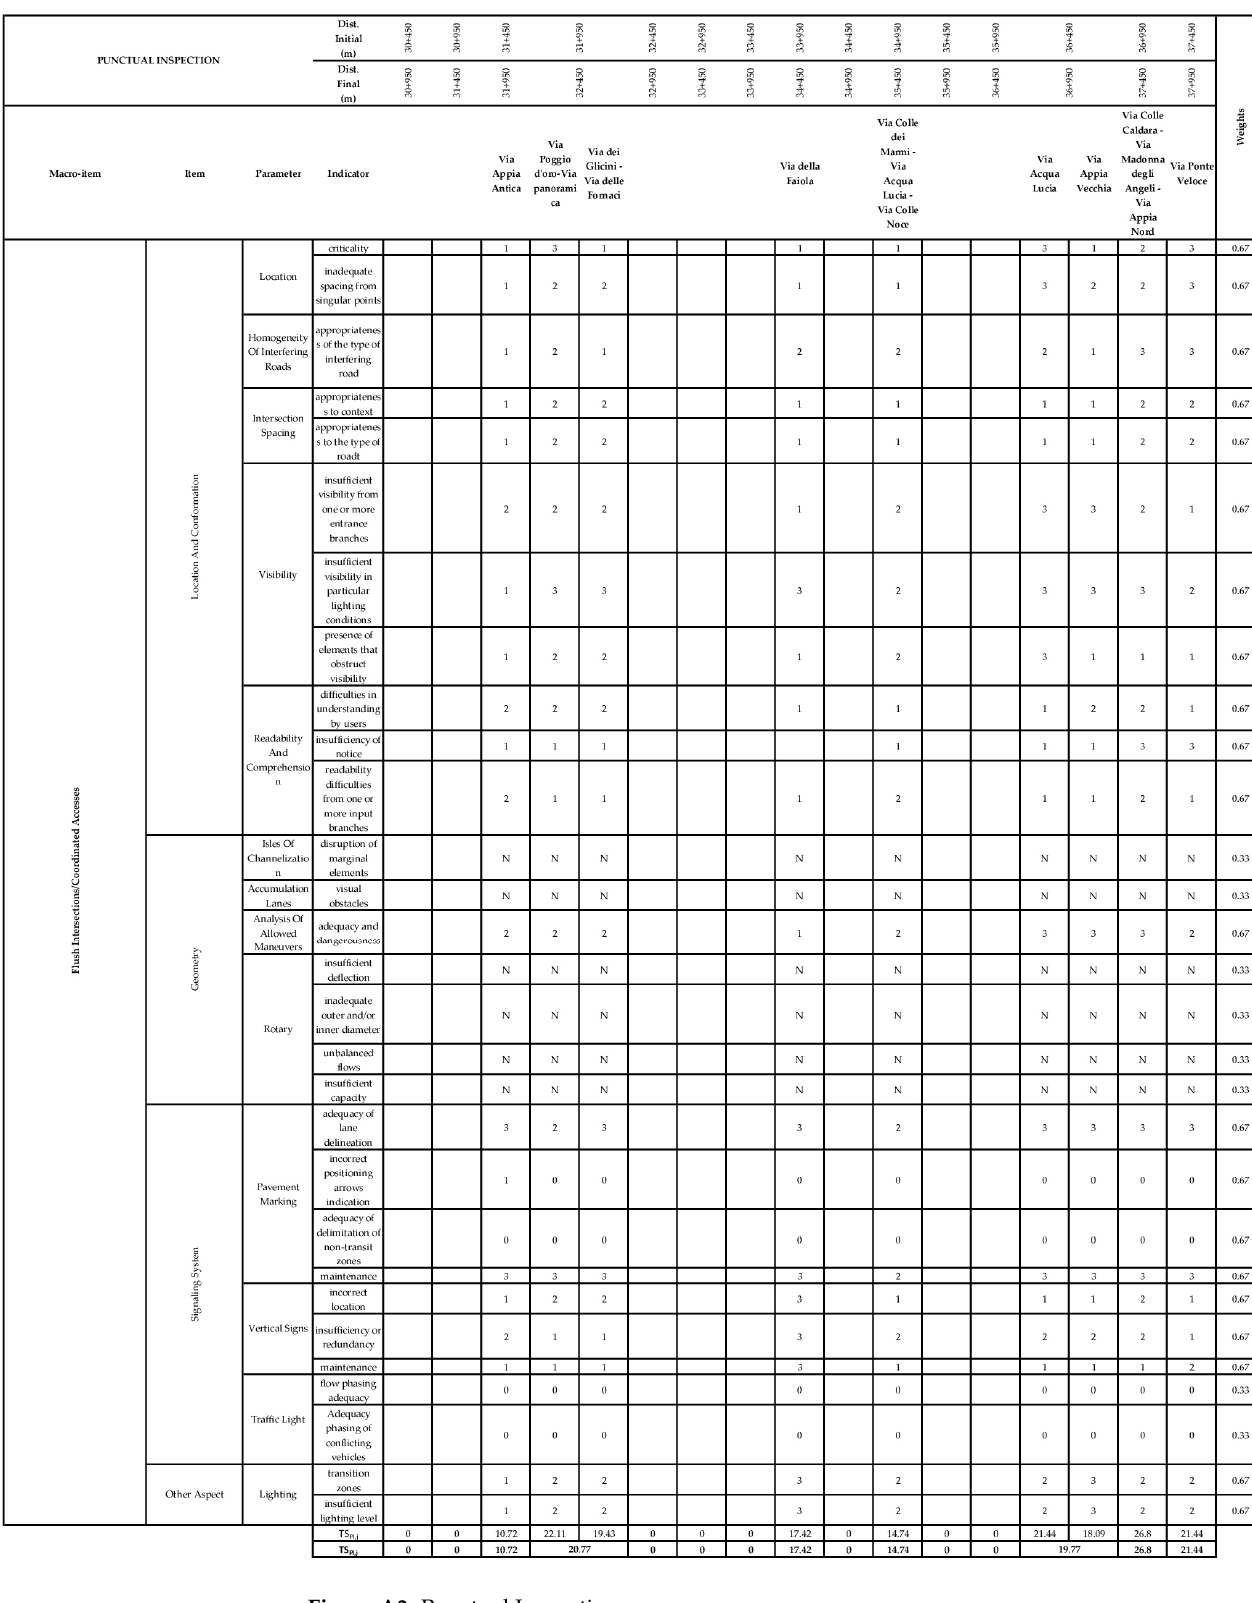
Figure A3. Punctual Inspection.